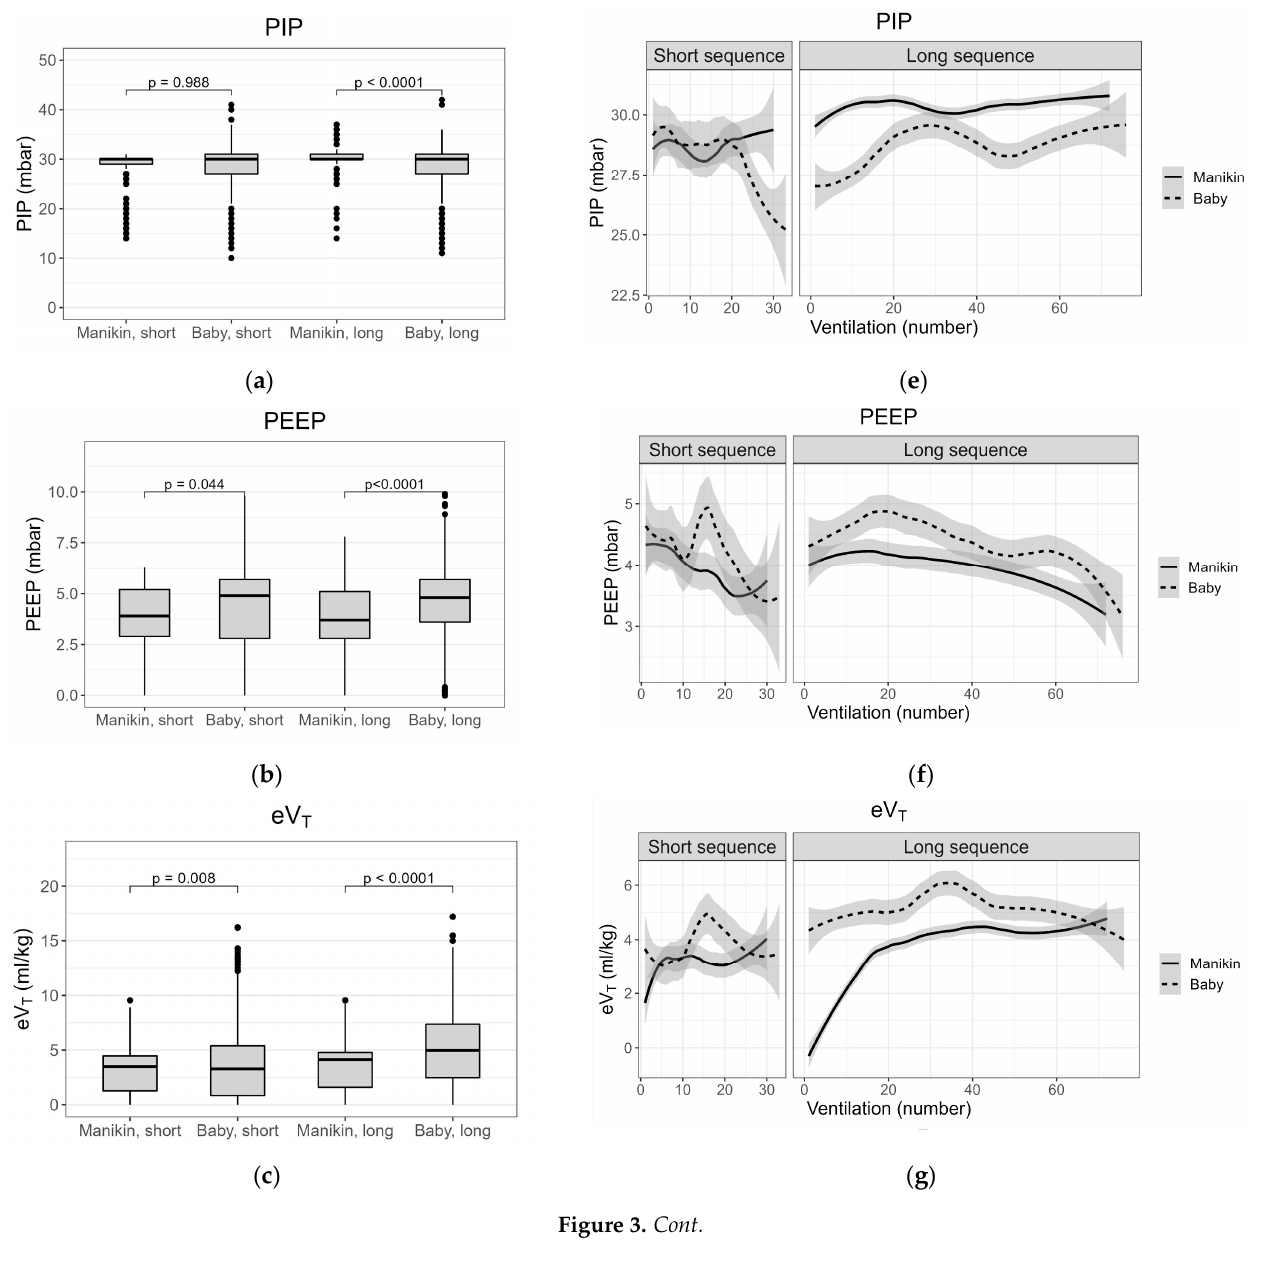
( h ) Figure 3. ( a – d ) Box plots of median (interquartile range; range) PIP (peak inflating pressure), PEEP (positive end-expira- tory pressure, eV T (expiratory tidal volume) and leak for groups Manikin Short (MS), Baby Short (BS), Manikin Long (ML) and Baby Long (BL); ( e – h ) Dynamical smoothed mean (standard error) plots of PIP, PEEP, eV T and leak for groups MS, BS, ML and BL. 3.3. Dynamical Correlation between Ventilatory Parameters For all four groups, dynamical correlation between PIP and eV T , PIP and leak, and leak and eV T are shown in Table 2. Pearson’s correlation coefficient, r, is given under the corresponding dynamical correlation coefficient, ρ .